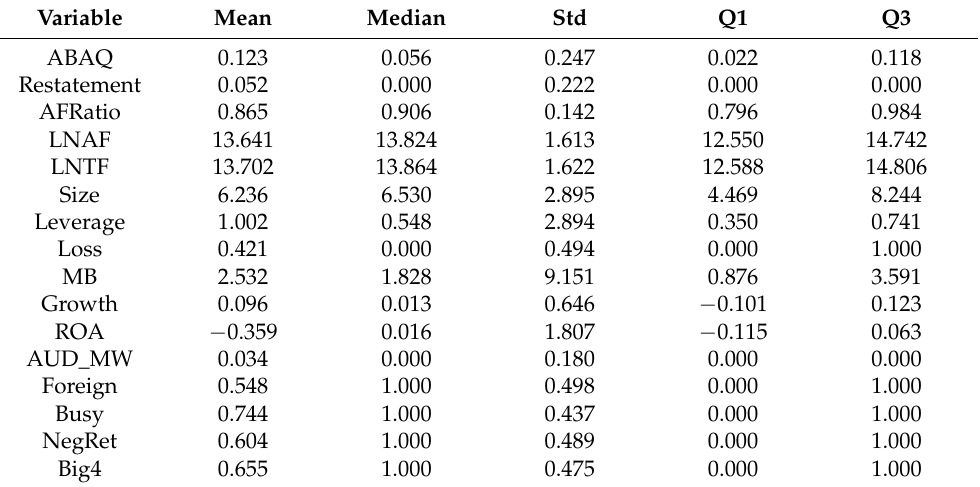
Table 2. Descriptive Statistics and Univariate Test for the U.S. Firms. Panel A: Descriptive Statistics for the ABAQ, Restatement, and AF of U.S. sample firms in 1-year pre-Rule 3211 period.